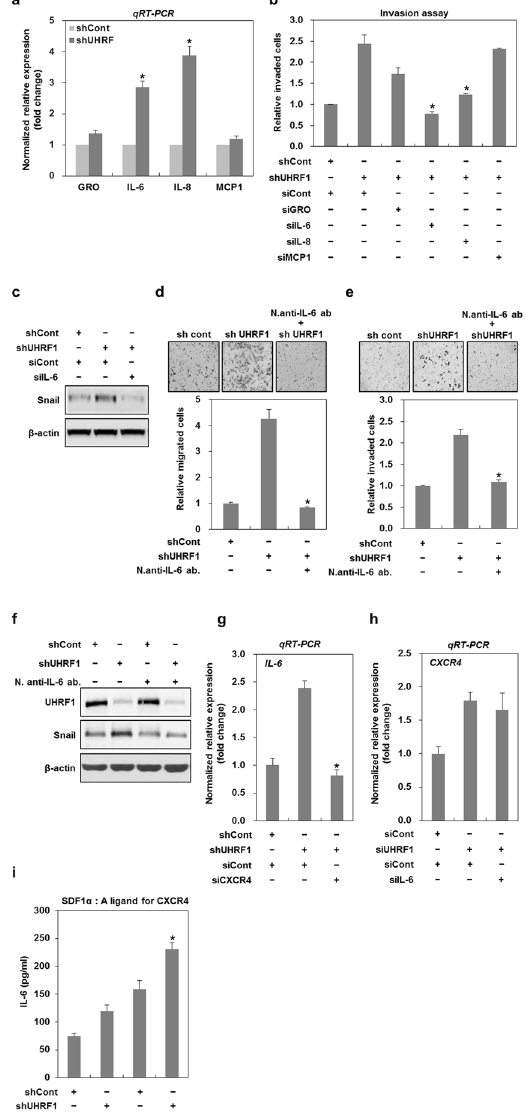
Figure 4. Downregulation of UHRF1 induces upregulation of IL-6 promoting EMT. ( a ) qRT-PCR analysis for the mRNA expression levels of GRO, IL-6, IL-8 and MCP1 in shCont- and shUHRF1-HepG2 cells. ( b ) Effects of siRNAs targeting GRO, IL-6, IL-8 and MCP1 on the invasive property of shUHRF1-HepG2 cells. The cells were grown in the presence or absence of siRNAs for 48 h, and the invasion assay was performed using the Transwell chamber. ( c ) Effect of siRNA targeting IL-6 on the protein expression level of Snail in shUHRF1- HepG2 cells. The cells were grown in the presence or absence of siRNA targeting IL-6 for 48 h, and western blot analysis was performed. ( d and e ) Effects of a neutralizing antibody of IL-6 on the migratory and invasive properties of shUHRF1-HepG2 cells. The cells were grown in the presence or absence of a neutralizing antibody of IL-6 for 48 h, and the migration and invasion assay were performed using the Transwell chamber. ( f ) Effects of a neutralizing antibody of IL-6 on the protein expression level of Snail in shUHRF1-HepG2 cells. The cells were grown in the presence or absence of a neutralizing antibody of IL-6 for 48 h, and western blot analysis was performed. ( g ) Effect of siRNA targeting CXCR4 on the mRNA expression of IL-6 in shUHRF1-HepG2 cells. The cells were grown in the presence or absence of siRNA targeting CXCR4 for 48 h, and qRT-PCR analysis was performed. ( h ) Effect of siRNA targeting IL-6 on the mRNA expression of CXCR4 in shUHRF1-HepG2 cells. The cells were grown in the presence or absence of siRNA targeting IL-6 for 48 h, and qRT-PCR analysis was performed. ( i ) Effect of SDF1 α (250 ng/ml) on the secretion of IL-6 from shUHRF1-HepG2 cells. The cells were grown in the presence or absence of SDF1 α for 48 h, and ELISA was performed to detect the secretion of IL-6 using conditioned medium obtain from the cells treated with SDF1 α . β -actin was used as a loading control. Results from three independent experiments are expressed as means ± SEMs. ( * P < 0.05, ** P <